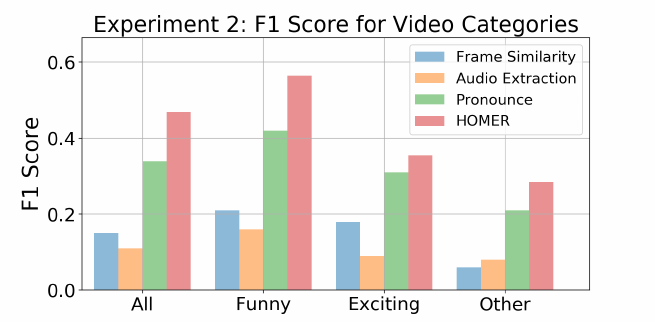
Figure 17. The mean F 1 scores of 20 VTW videos for different video